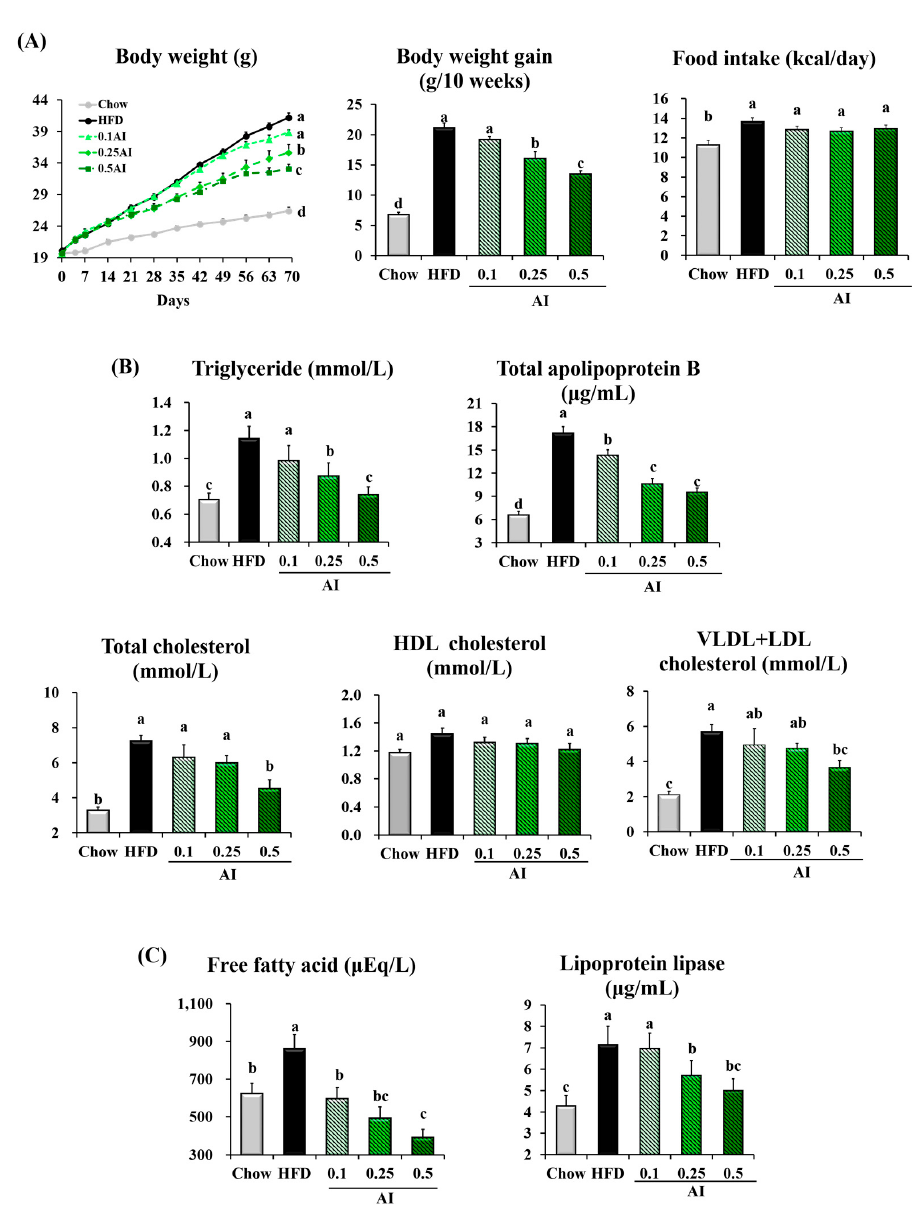
Figure 2. AI attenuates hypertriglyceridemia in high-fat diet (HFD)-fed mice. ( A ) Changes in body weight and food intake; ( B ) plasma levels of triglyceride, total apolipoprotein B, total cholesterol, very low density lipoprotein (VLDL) + LDL cholesterol, and high density lipoprotein (HDL) cholesterol; ( C ) plasma free fatty acid and lipoprotein lipase concentrations. Data are the mean ± standard error of the mean (SEM) of n = 8 mice. Statistical analysis was performed using one-way analysis of variance (ANOVA) and analyzed further by Duncan’s multiple range test. Different letters above the bars indicate significant differences among experimental groups ( p <